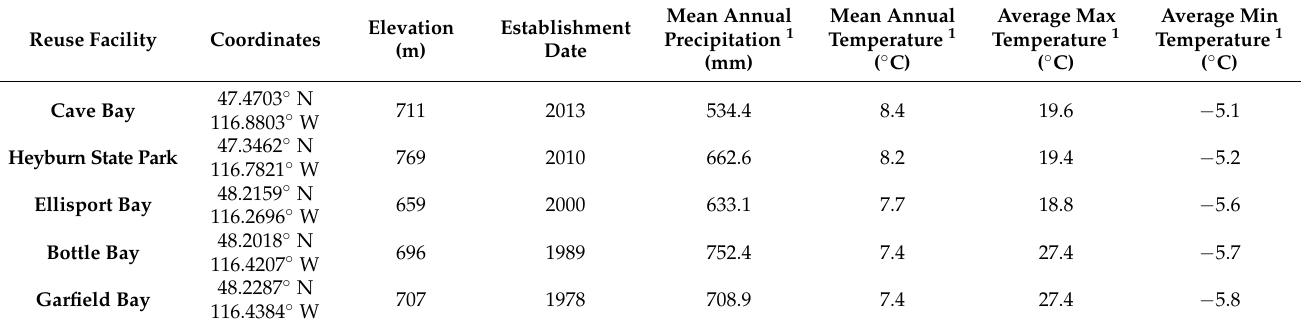
Figure 1. Study area: water reclamation facilities in northern Idaho, USA. Table 1. Study facility information, including location, elevation, establishment date, mean annual precipitation, mean annual temperature, average maximum temperature and average minimum